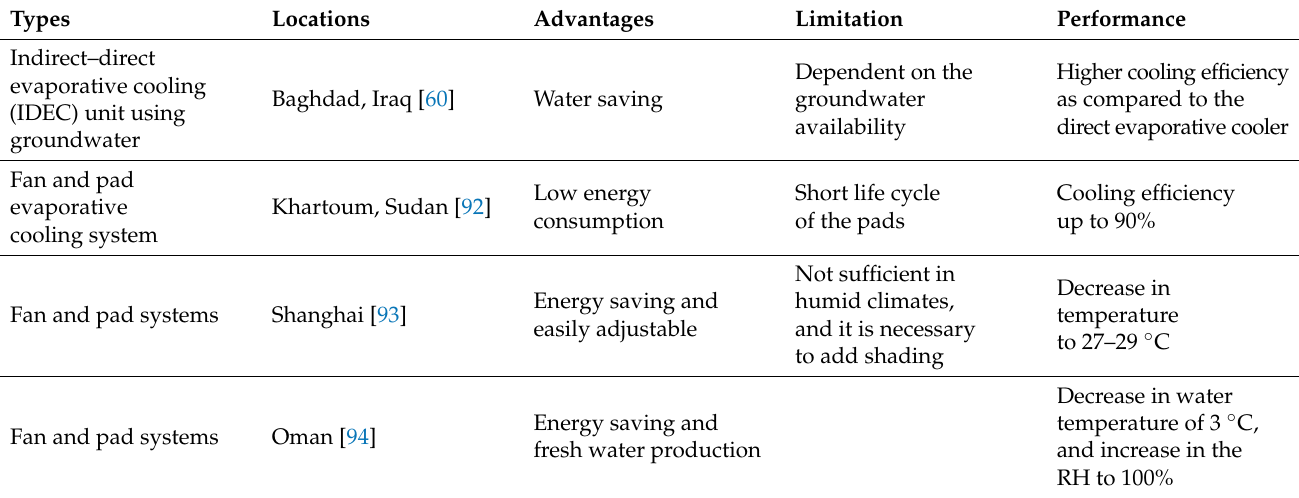
Table 2. Evaporative cooling systems used in greenhouses in arid and hot regions.